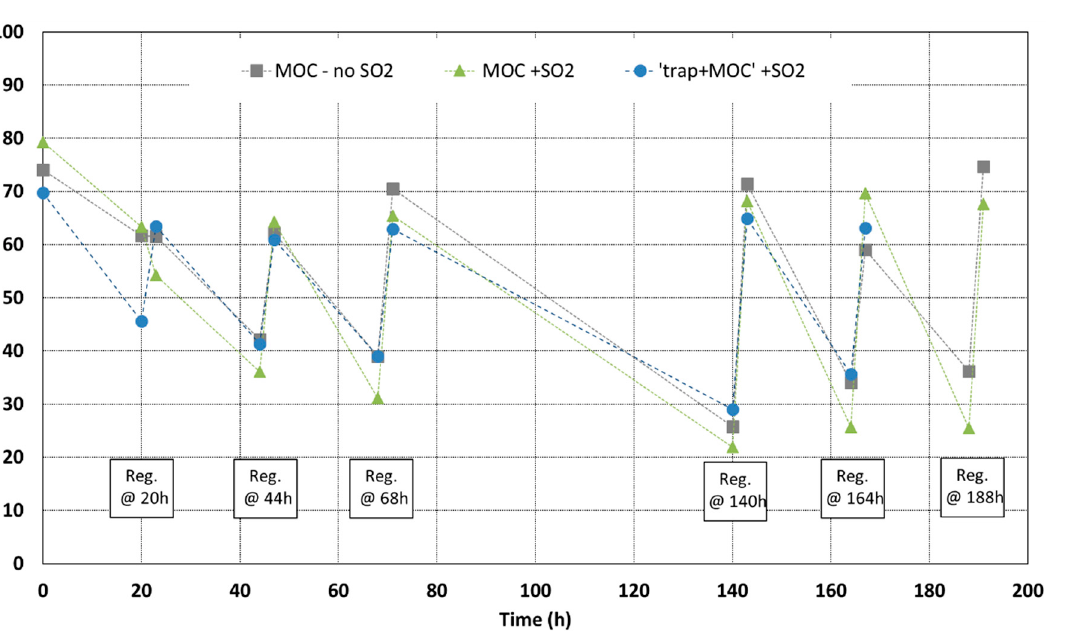
Figure 3. Methane conversion as a function of time, over the ageing experiment, calculated from GC results. GC measure- ments were done just before regeneration and 3 h after the regeneration. (The lines are to guide eye only).